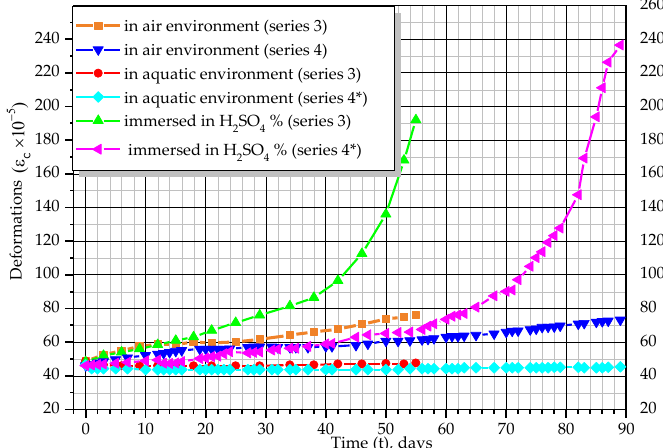
Figure 10. Changes of average deformations of concrete over time.